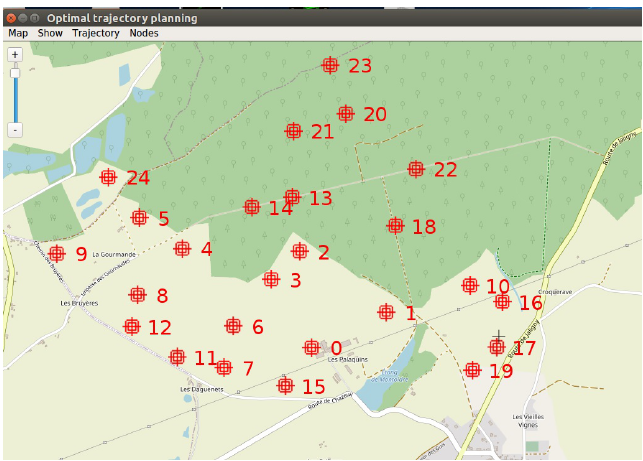
Figure 18. Development of a trajectory planning software in C++, displayed with OpenStreetMap. 25 buried nodes are distributed in the environment. Beforehand the use of evolutionary algorithms, these coordinates are converted into metrics coordinates using the french transformation Lambert.